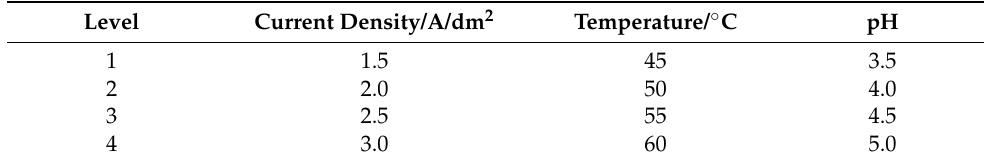
Table 1. Table of Factor Levels for Orthogonal